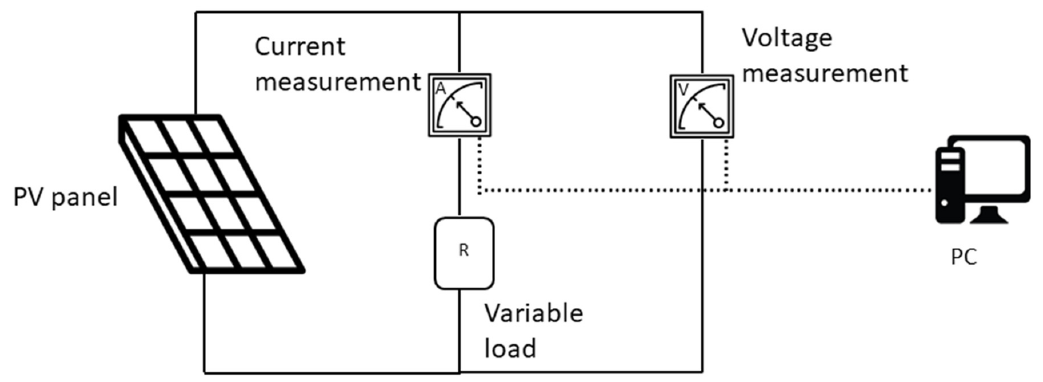
Figure 7. Experimental setup of electrical measurements.